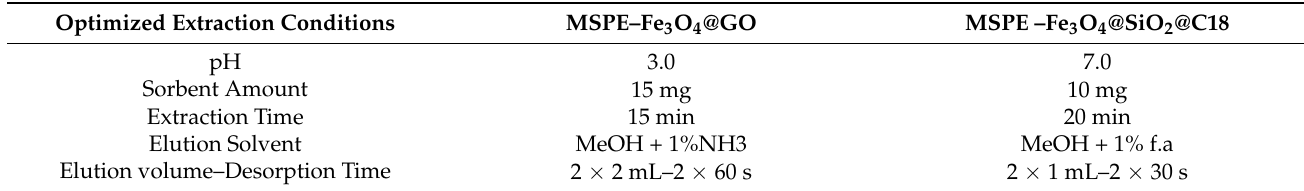
Table 1. Optimal parameters of MSPE with Fe 3 O 4 @GO and Fe 3 O 4 @SiO 2